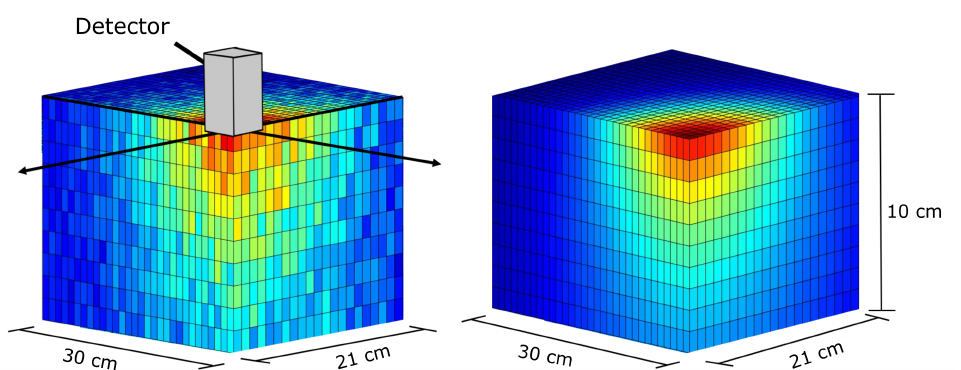
Figure 2. Quadrant cross-section of the as measured Detector Response Function ( left ) and the fitted model Detector Response Function ( right ). On the left-hand image, a model detector crystal (collimator and aluminium case not shown) is superimposed to highlight the experimental method. The detector crystal is outlined as an oblong shape with finite volume, although the algorithm assumed a perfect point, and all distances and angles are measured relative to the centre of the